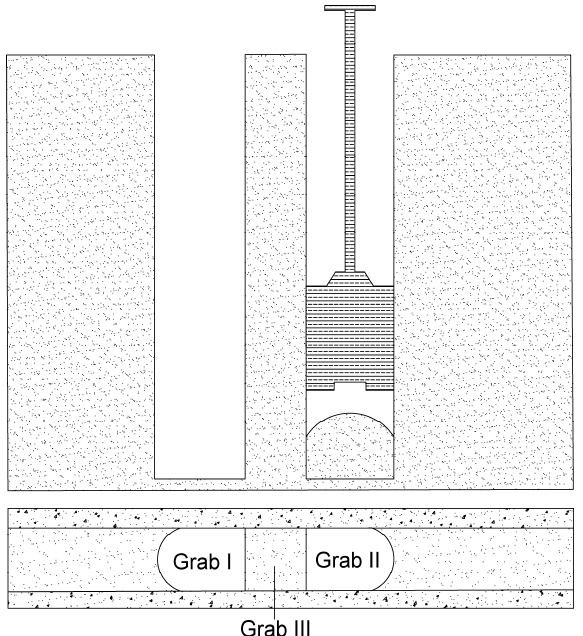
Figure 7. Jump-excavation method during the trench excavation.